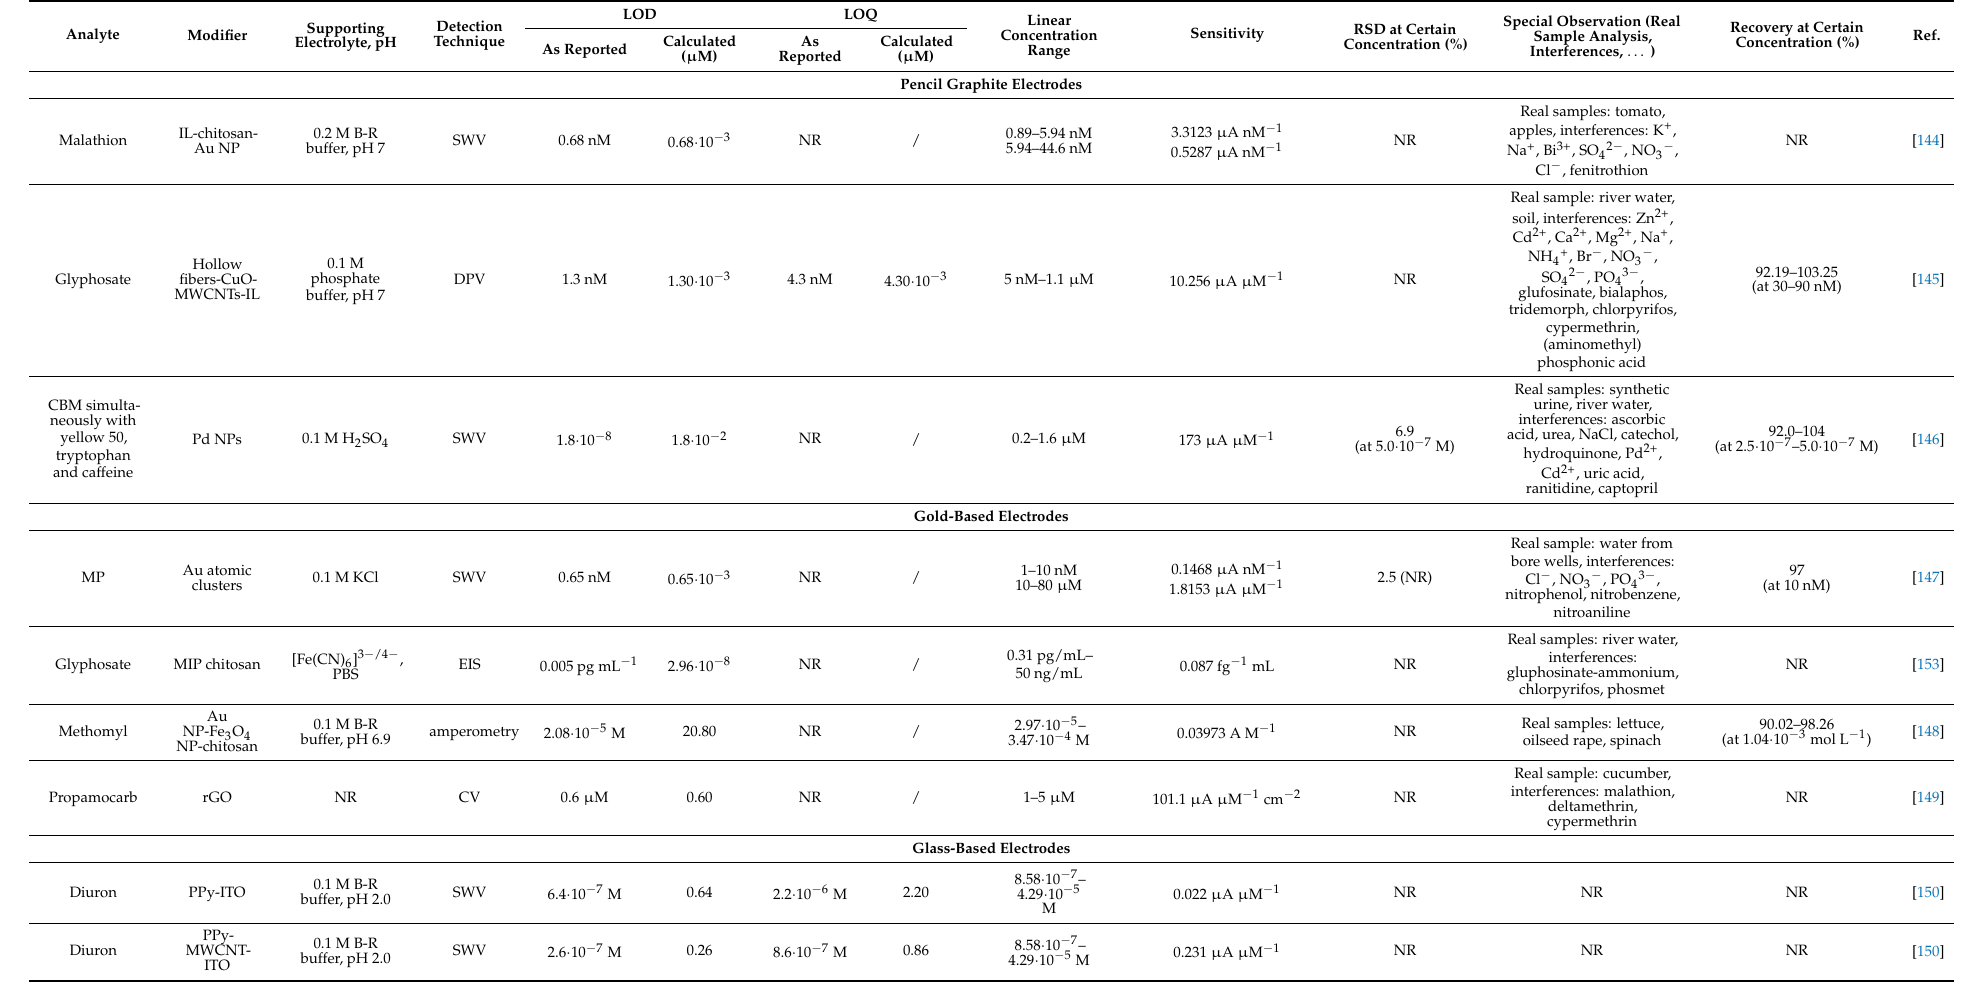
Table 4. Data of recently reported electrochemical sensors for non-enzymatic pesticide detection using other types of electrodes.